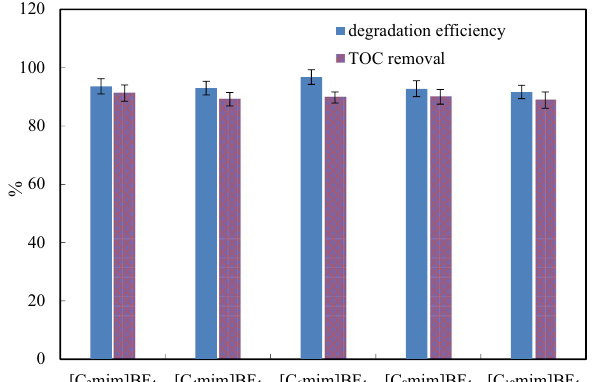
Figure 9. TOC removal of [C n mim][BF 4 ] (1 mmol/L) in US-ZVZ/AC system: [AC] = 0.15 g, [ZVZ] = 0.15 g, pH = 3.0 and ultrasound frequency = 45 kHz at 30